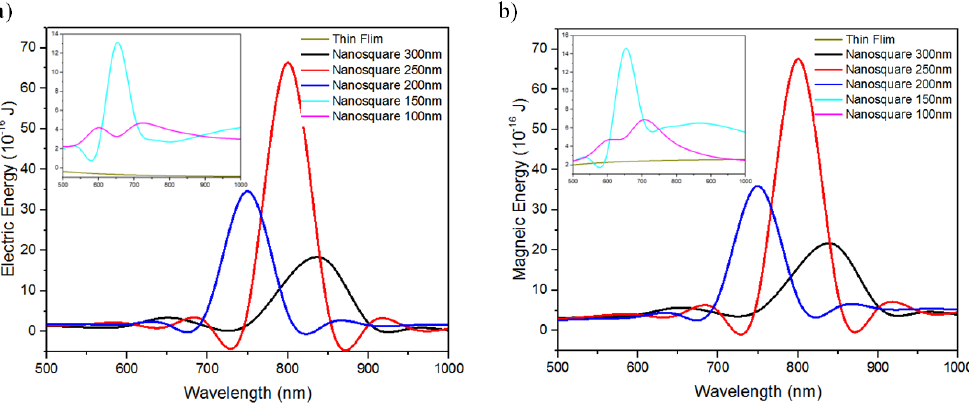
Figure 4. Simulation result of ( a ) electric energy and ( b ) magnetic energy from Ag thin films and Ag nanosquares with diameters of 100, 150, 200, 250, and 300